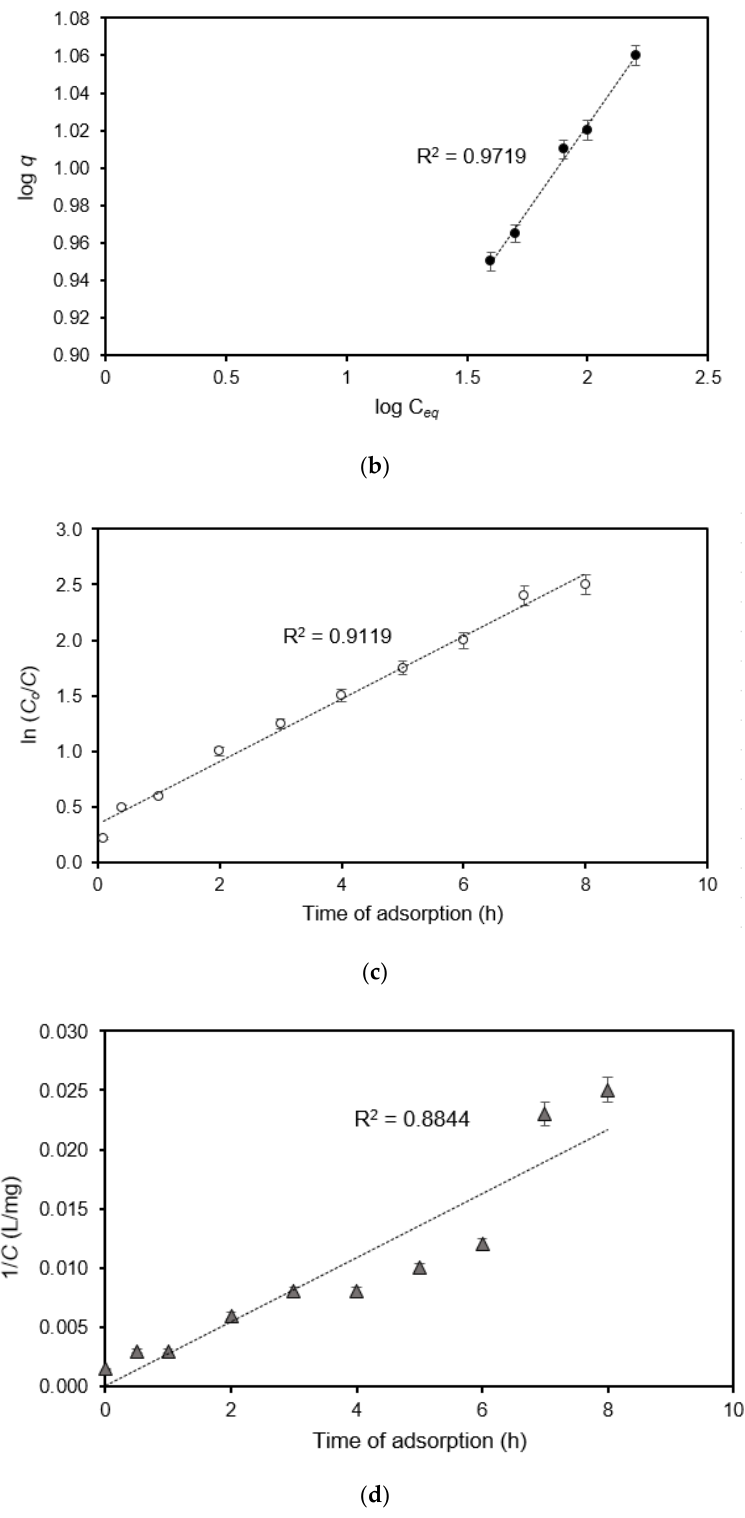
Figure 3. Adsorption of PB dye using Sterculia alata biochar: ( a ) Langmuir isotherm; ( b ) Freundlich isotherm; ( c ) pseudo-first order kinetics; ( d ) pseudo-second order kinetics.